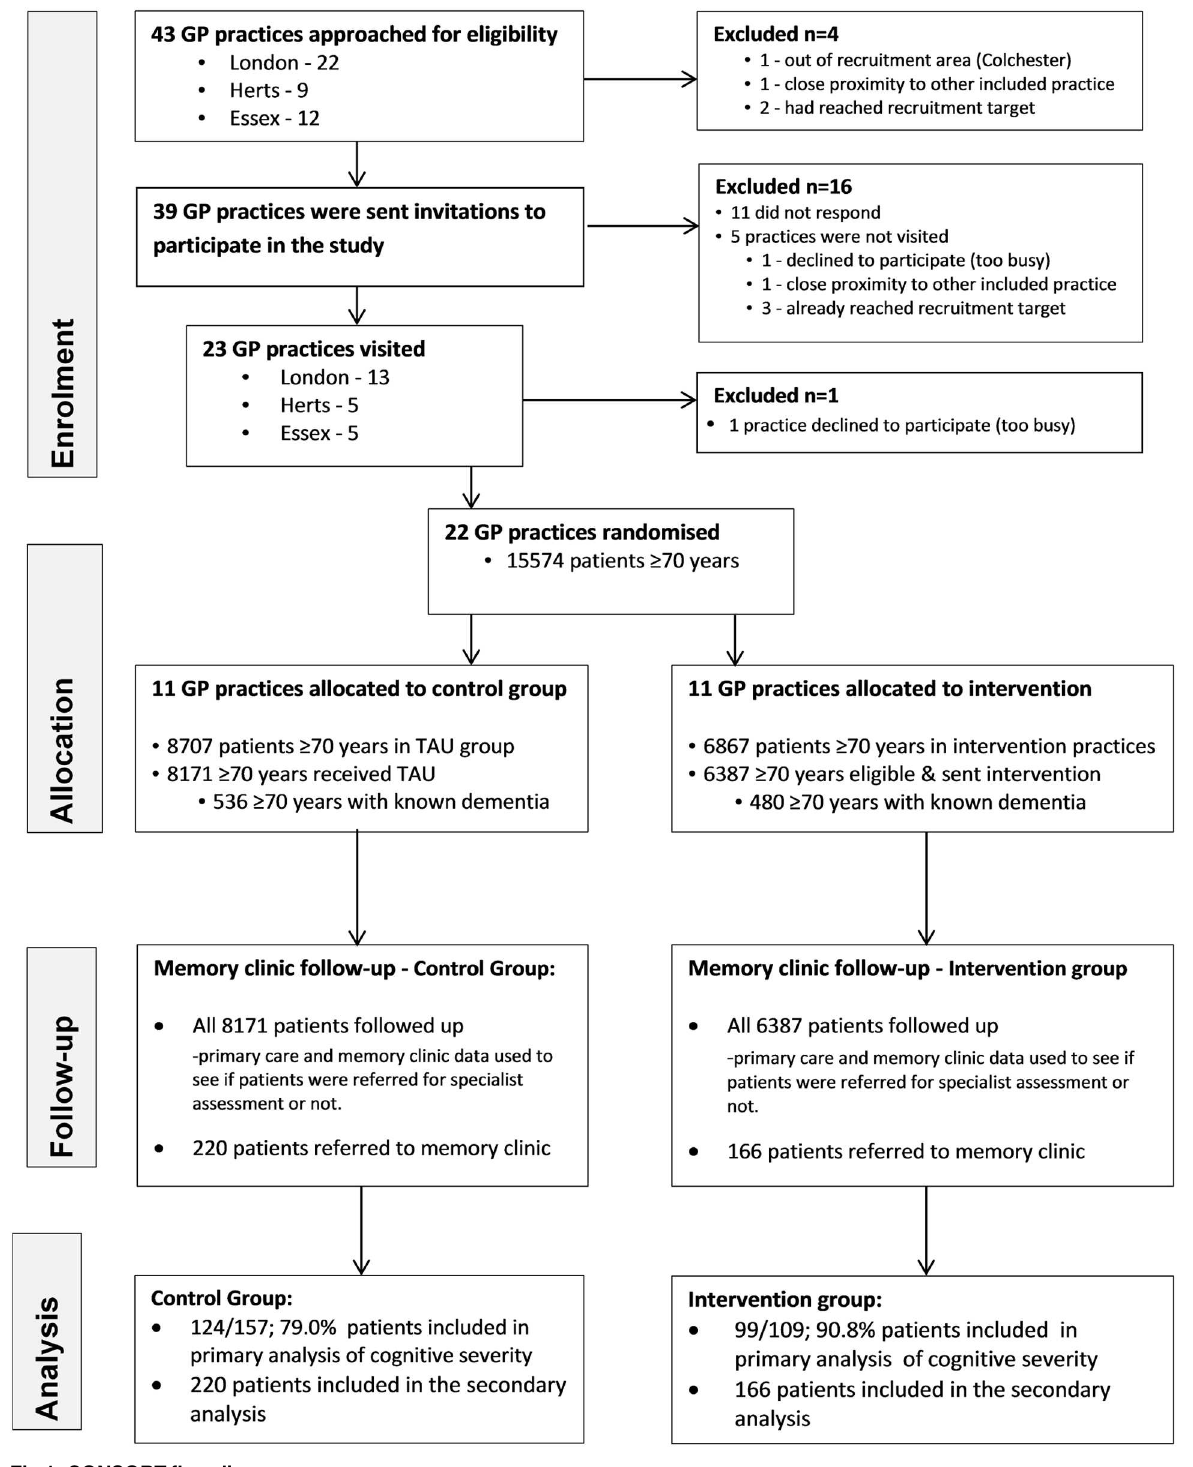
Fig 1. CONSORT flow diagram.